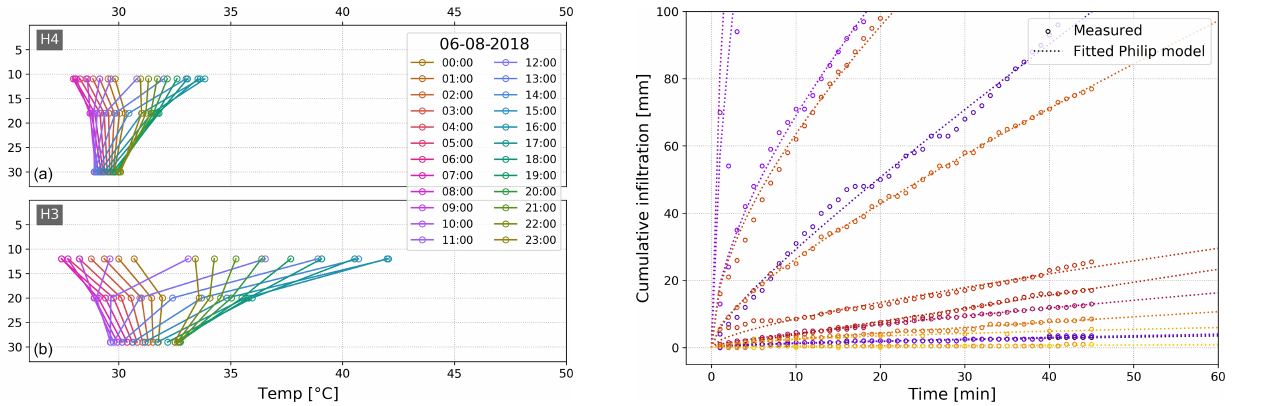
Figure 11. Measured infiltration and simulation with the Philip in- filtration